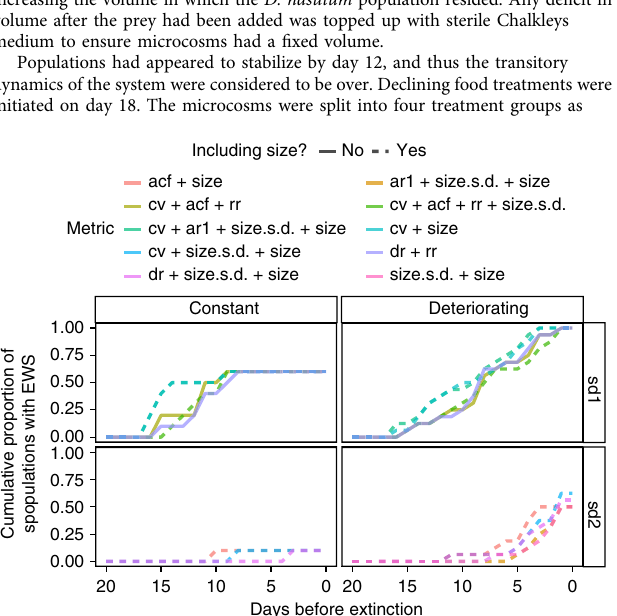
Figure 5 | Realized population growth rates in successive time intervals for each population across the four experimental treatments. For general density-dependent growth in a deteriorating environment, a bifurcation occurs when the non-linear growth rate drops below 1. Thus, we inferred a bifurcation to have occurred at the last time before extinction of a population that the realized growth rate dropped below 1 (grey vertical lines). One population in the constant environment treatment, seven in the fast degrading environment, four in the medium and five in the slow treatments appeared to cross this threshold. Vertical blue lines indicate the start of the declining food treatments (day 18, where